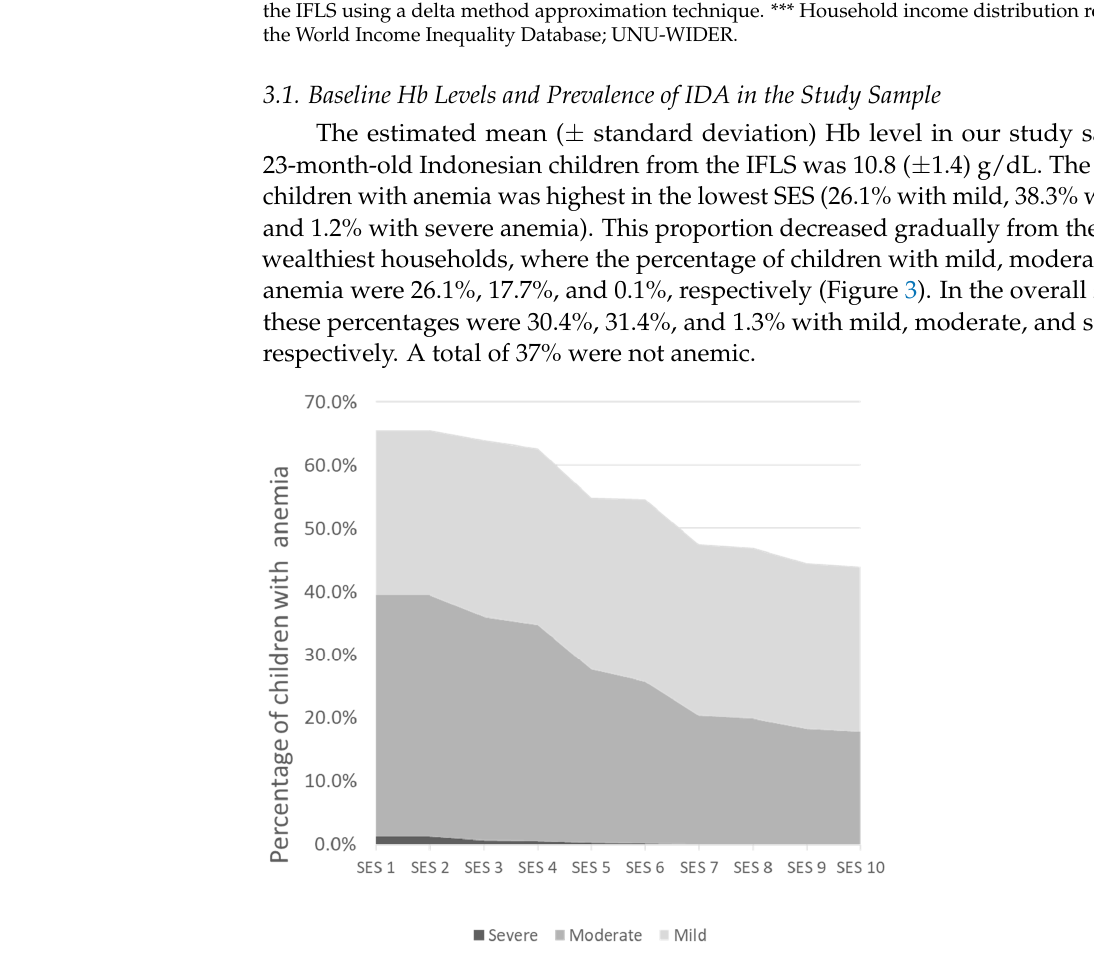
Figure 3. Percentage of 6 to 23-month infants and young children with anemia across the 10 socio- economic strata (SES). 3.2. Estimated Level and Duration of Consumption of Fortified Infant Cereals in 6 to 23-Month-